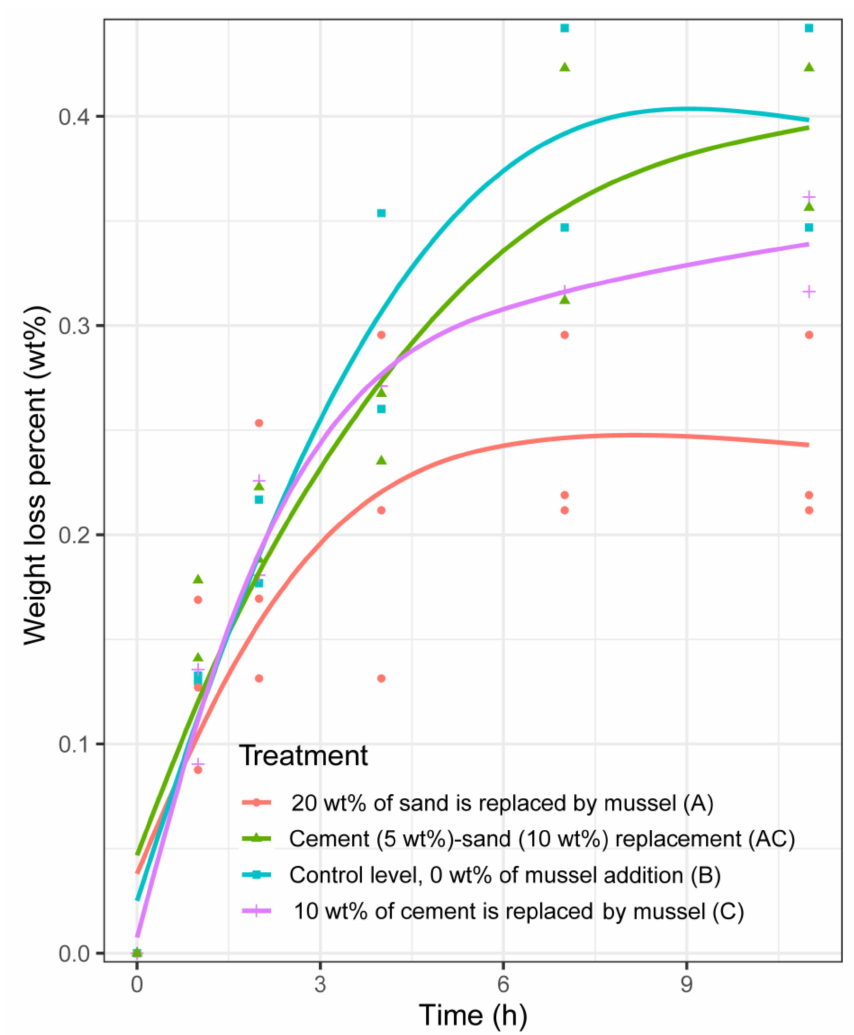
Figure 10. GAM model fittings to the weight loss corresponding to each level of mussel replace- ment